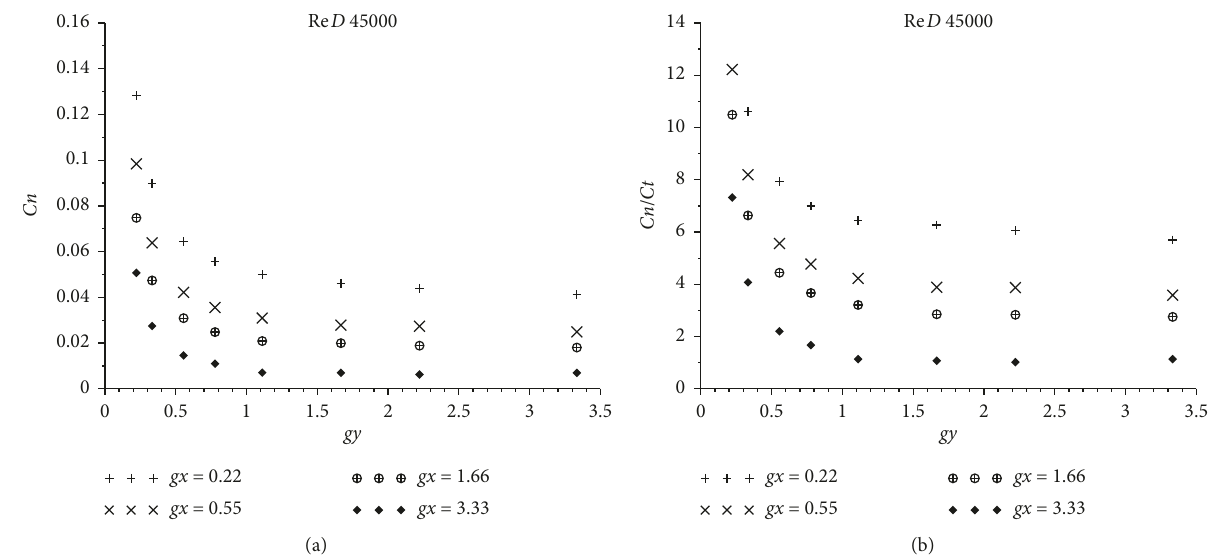
Figure 7: Evolution of Cn (a) and Cn / Ct (b) as a function of gy